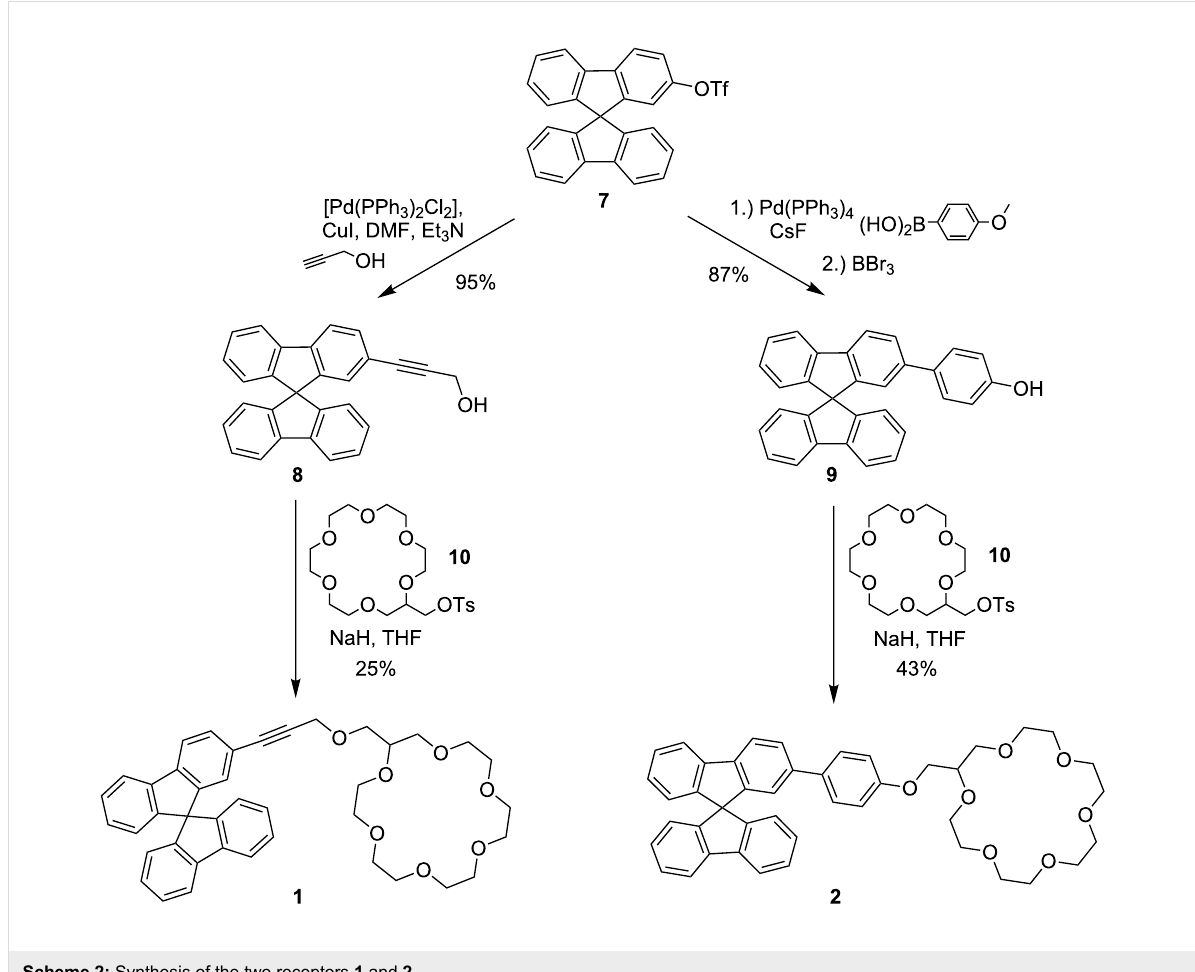
Scheme 2: Synthesis of the two receptors 1 and 2